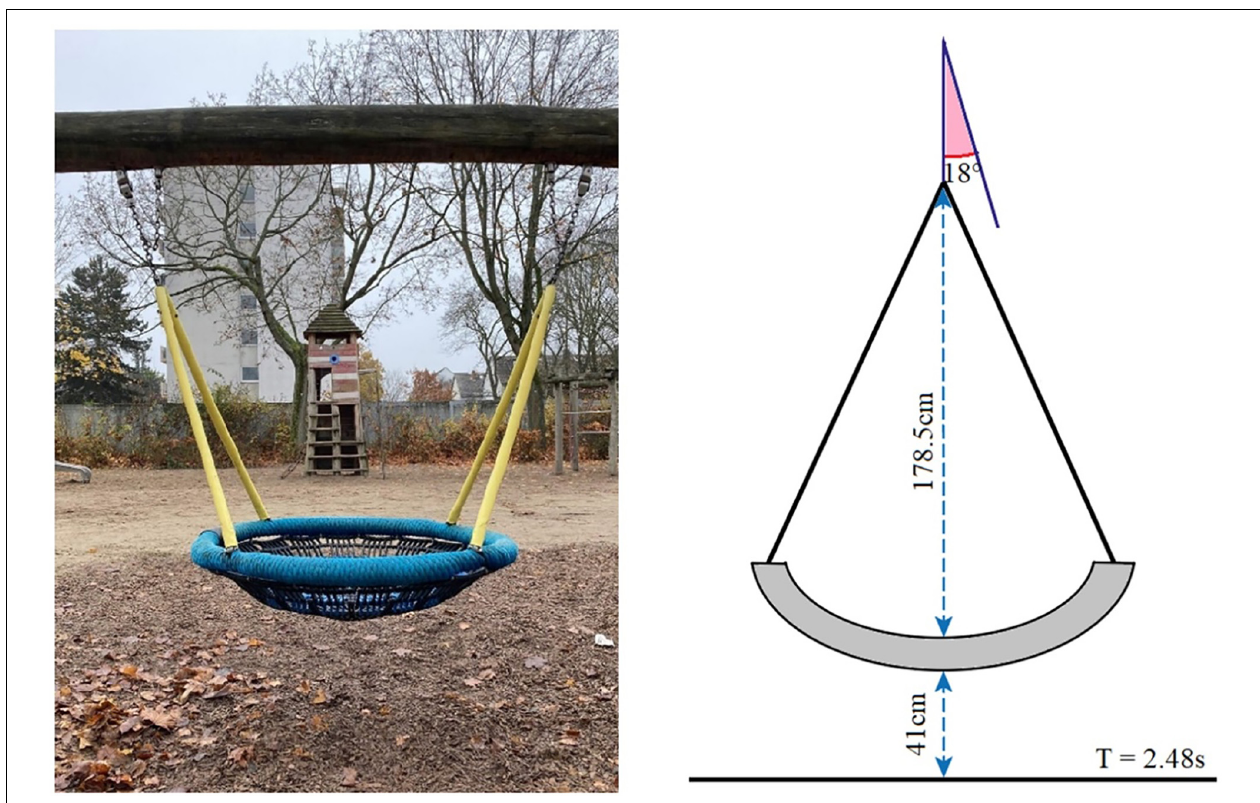
FIGURE 1 | Nest swing used in Experiment